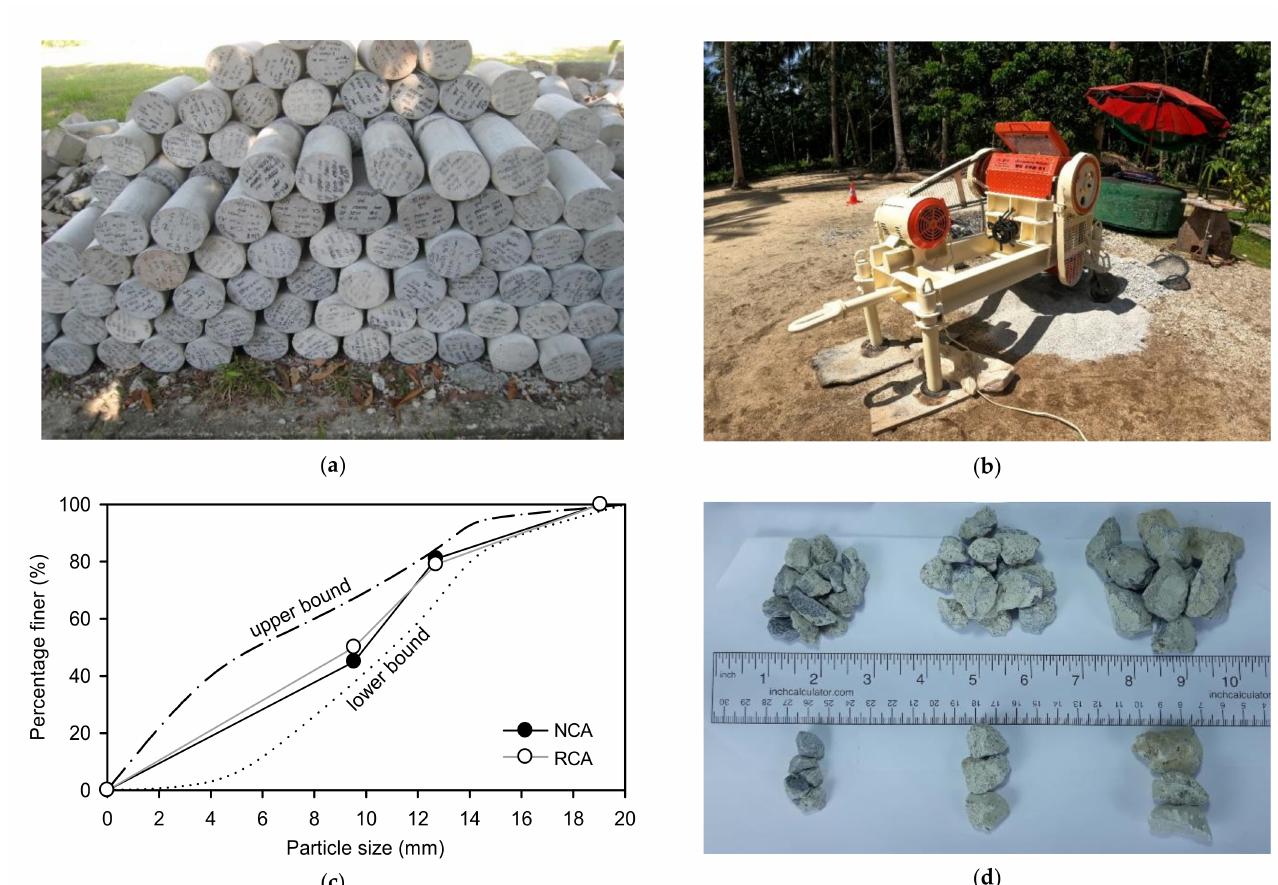
Figure 1. ( a ) Concrete cylinder waste ( b ) Custom-made crushing machine ( c ) Coarse aggregate sieving test results, and ( d ) View of recycled coarse aggregate